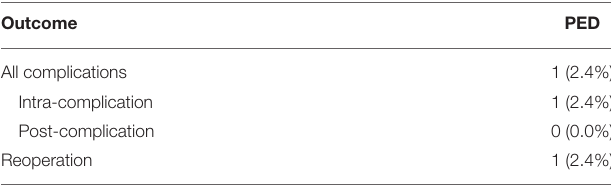
TABLE 2 | Complication and reoperation of included